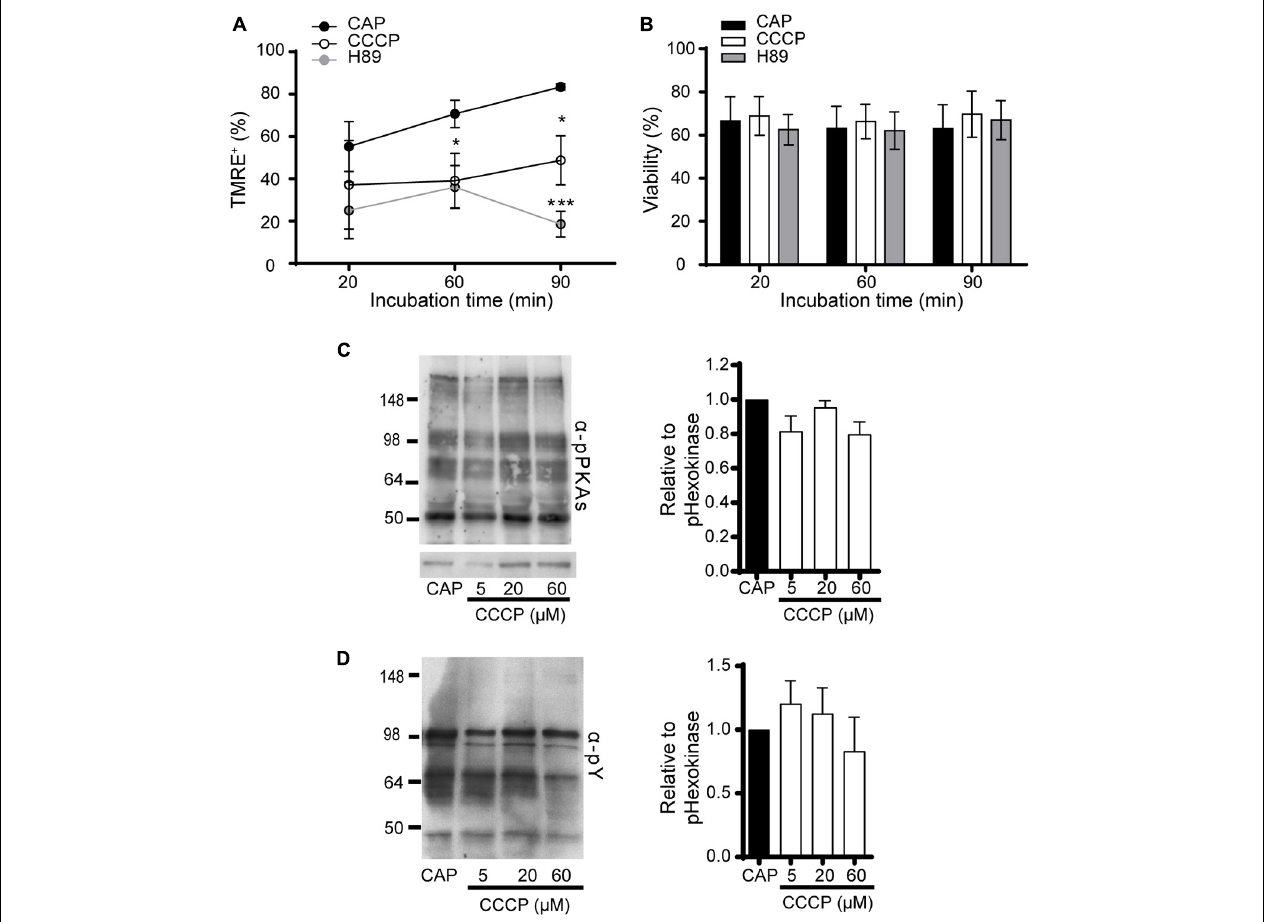
FIGURE 3 | Association between the increase in mitochondrial activity and capacitation in mouse sperm. (A,B) Epididymal sperm were incubated in the capacitation medium containing CCCP (20 µ M), H89 (20 µ M) or DMSO (capacitated sperm, CAP), loaded with TMRE, and fluorescence was measured by flow cytometry. The following parameters were scored: (A) Percentage of sperm exhibiting TMRE + signal. (B) Percentage of viability from experiments shown in (A) . Results are expressed as mean ± SEM. n = 5. * p < 0.05, *** p < 0.001. (C,D) Epididymal sperm were incubated in the capacitation medium containing CCCP (5–60 µ M) or DMSO (capacitated sperm, CAP), and analyzed by Western blotting for phosphorylation (C) in PKA substrates ( α -pPKAs) and (D) in tyrosine residues ( α -pY). Representative blots are shown on the left. Right panels correspond to quantification graphs of each phosphorylation normalized to CAP. At least 3 independent experiments were